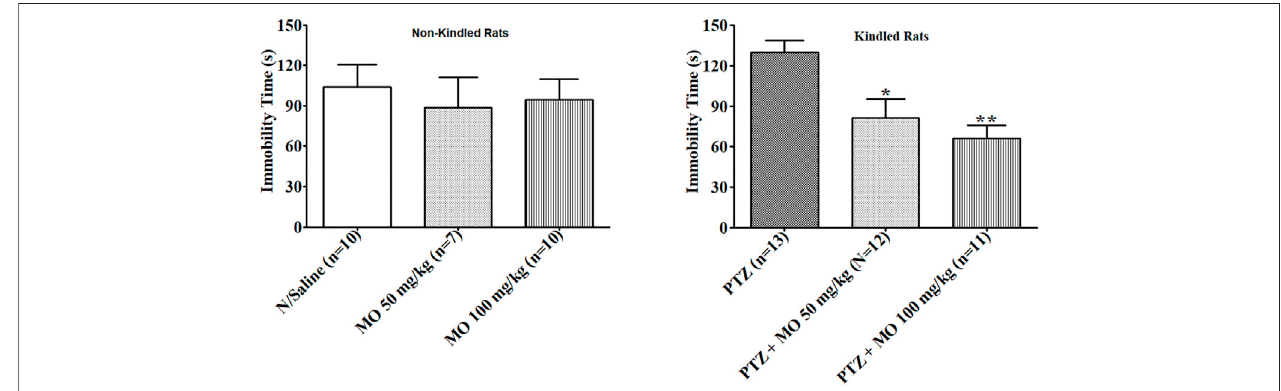
FIGURE 7 | Effects of Melissa of fi cinalis L. essential oil (MO) on duration of immobility in forced swim test in PTZ-kindled rats. * p < 0.05 (PTZ vs PTZ + MO 50 mg/kg); ** p < 0.01 (PTZ vs PTZ + MO 100 mg/kg). n (cid:2) number of animals tested. Mean ± SEM.